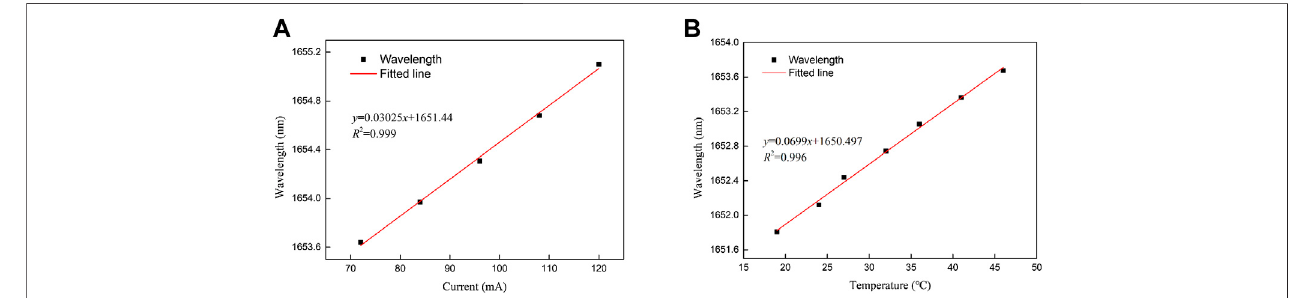
FIGURE 2 | The stability of the absorption spectrum of the laser light intensity absorbed by 10% methane gas.